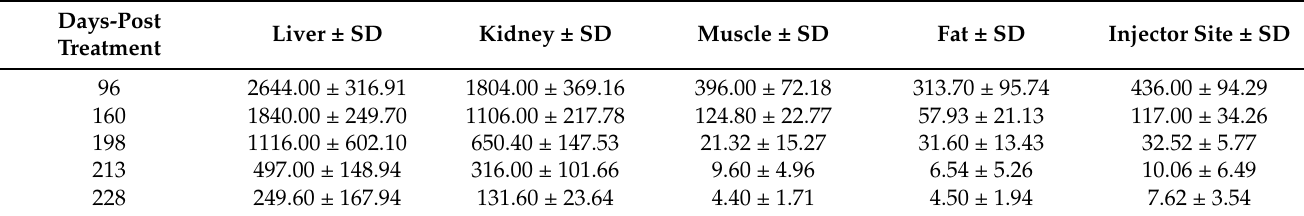
Table 6. IMD concentrations ( µ g/kg) in bovine tissue